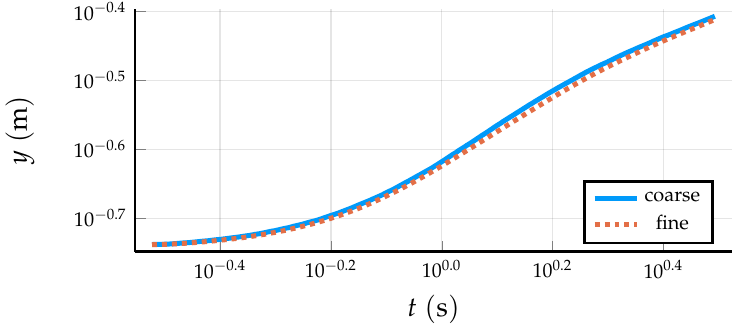
Figure 3. Front propagation for identical simulations of viscosity µ = 1.4 with two mesh partitions. The coarse corresponds to 60 cells in the x -direction, while the fine has 80.